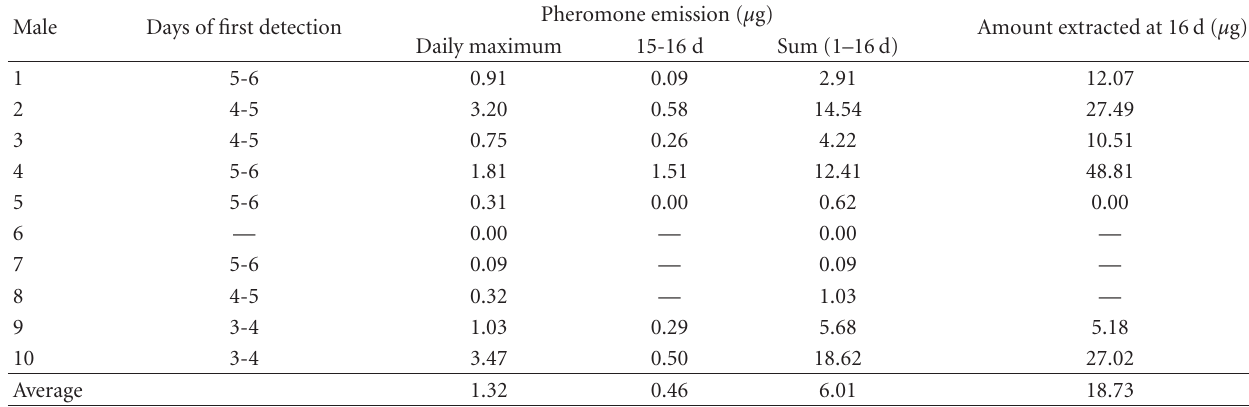
Table 1: Individual variation of pheromone titer and extraction from Piezodorus hybneri males.